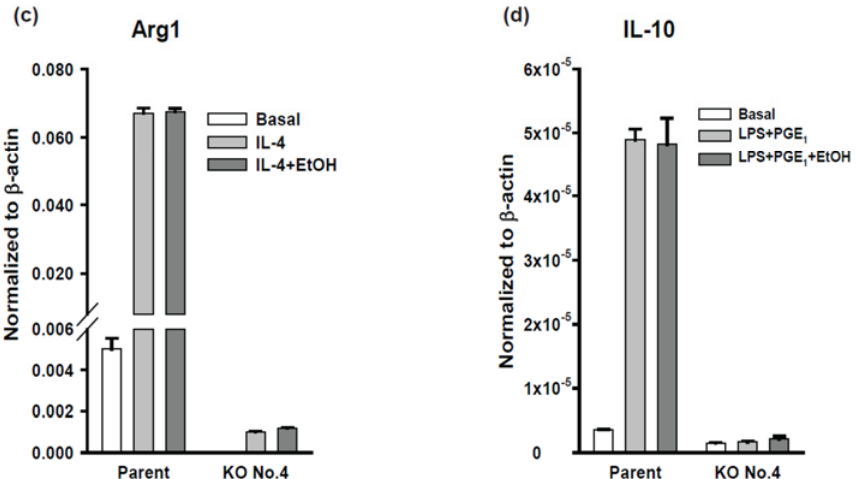
Figure 5. Activation of BV-2 AC7 KO cells. ( a ) The quantity of iNOS mRNA was measured by qRTPCR after activation with no drugs (Basal), 3 ng/mL lipopolysaccharide (LPS) plus 40 U/mL interferon (IFN) ‐γ or 3 ng/mL LPS plus 40 U/mL IFN ‐γ plus 50 mM ethanol as indicated. The expression level of mRNA was normalized to β‐ actin mRNA in the same sample. Data are represented as mean ± SEM in triplicate. The basal value for KO No.4 is 4.8 × 10 − 5 ± 4.0 × 10 − 6 . * indicates the value is significantly larger than the corresponding LPS + IFN value at p < 0.05 using one ‐ way ANOVA. ( b ) NO production was assessed by measuring nitrite in the culture medium as described in the Section 4 Materials and Methods. Cells were incubated with 3 ng/mL LPS and indicated concentrations of IFN ‐γ with or without 50 mM ethanol. Data are represented as mean ±